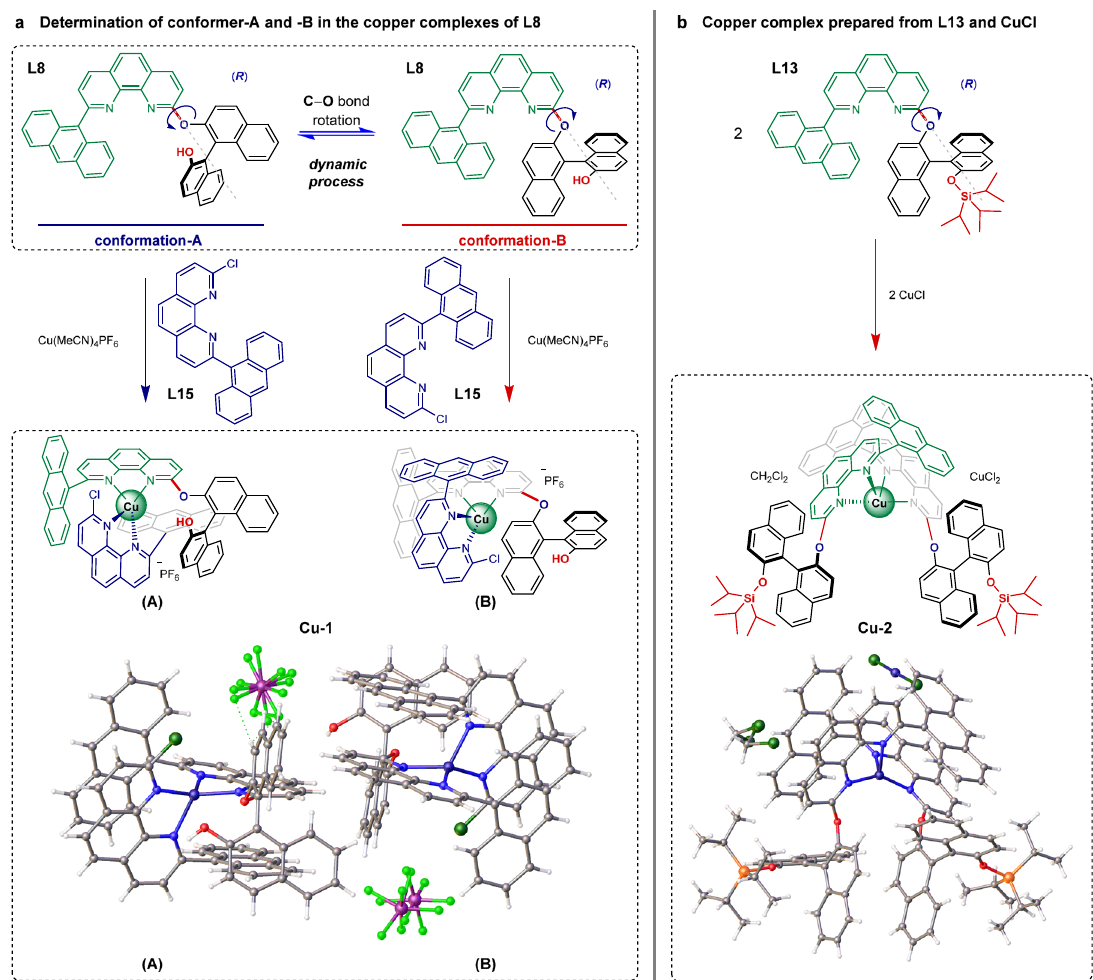
− 9-chloro-1,10-phenanthroline ( L15 ). b Copper complex Cu-2 prepared from L13 and